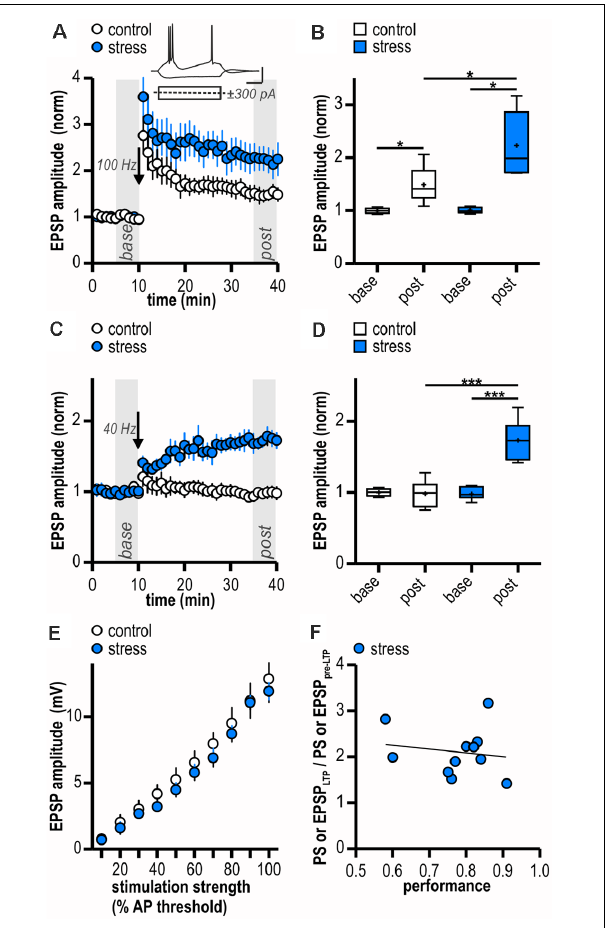
FIGURE 2 | Facilitated excitatory LTP in ventral subicular burst-spiking neurons following acute stress in adulthood. (A) Time course of mean normalized excitatory post synaptic potentials (EPSP) amplitudes at CA1—subiculum synapses to burst-spiking pyramidal neurons. Inset shows sample voltage responses of a subicular bursting neuron to depolarizing ( + 300 pA) and hyperpolarizing ( − 300 pA) current pulses. LTP at glutamatergic CA1—subiculum burst-spiking synapses following HFS (arrow, 100 Hz) is enhanced in stressed rats. (B) Quantification of mean normalized EPSP amplitudes (control: n = 6/4, paired Student’s t -test, * p < 0.05; stress: n = 5/4, paired Student’s t -test, * p < 0.05; control vs. stress, unpaired Student’s t -test, * p < 0.05). (C) Attenuated HFS (arrow, 10 pulses at 40 Hz) induces LTP at glutamatergic CA1—subiculum synapses selectively in stressed rats. (D) Quantification of mean normalized EPSP amplitudes (control: n = 6/5, paired Student’s t -test, p = 0.83; stress: n = 8/8, paired Student’s t -test, *** p < 0.001; control vs. stress, unpaired Student’s t -test, *** p < 0.001). (E) Stress experience does not alter basal excitatory synaptic